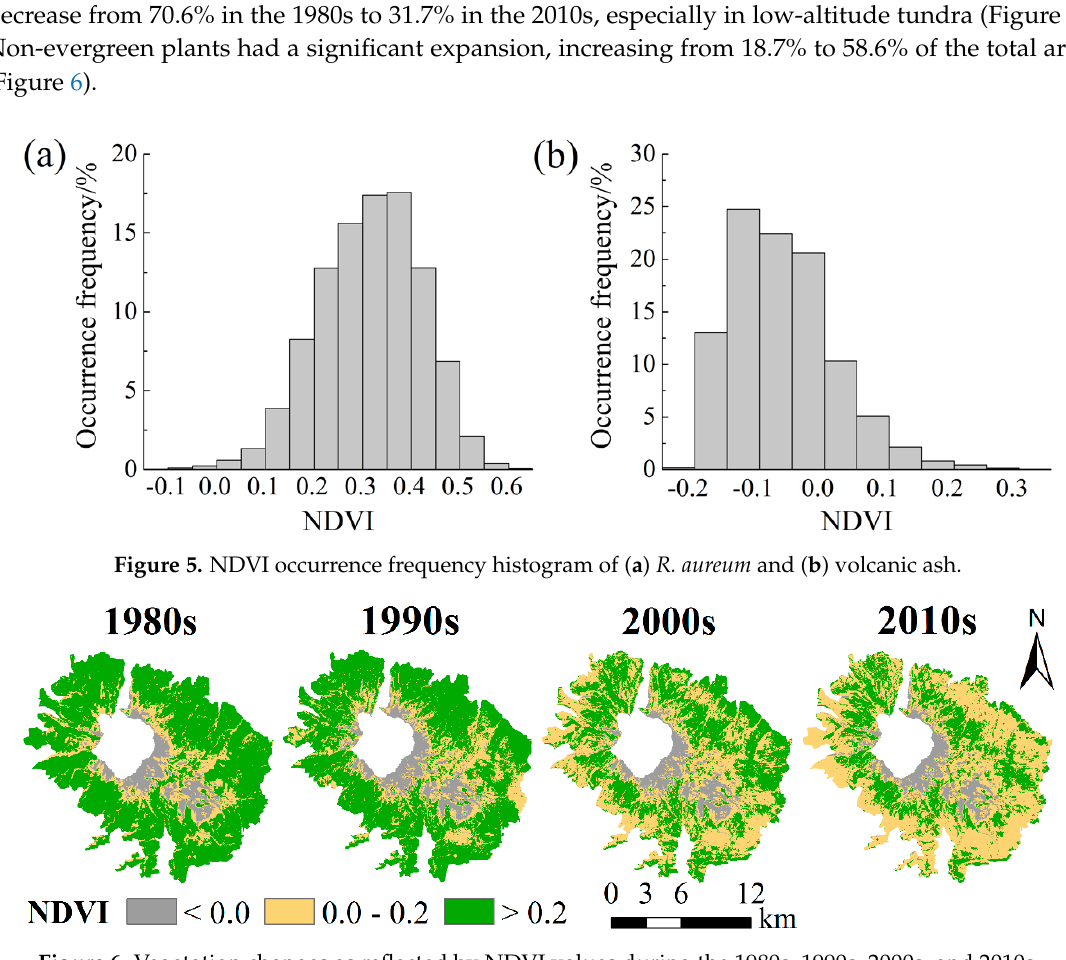
Figure 6. Vegetation changes as reflected by NDVI values during the 1980s, 1990s, 2000s, and 2010s, respectively. The NDVI value represents the average of the Landsat NDVI for the relevant decade. NDVI < 0.0 represents volcanic ashes, 0.0–0.2 represents non-evergreen plants, and >0.2 represents R. aureum .